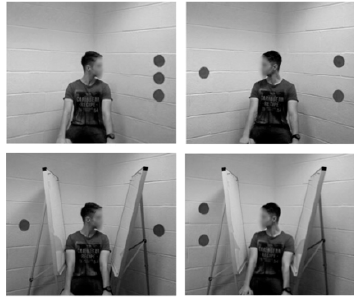
Figure 3. Example of the stimuli used by Langton [28].